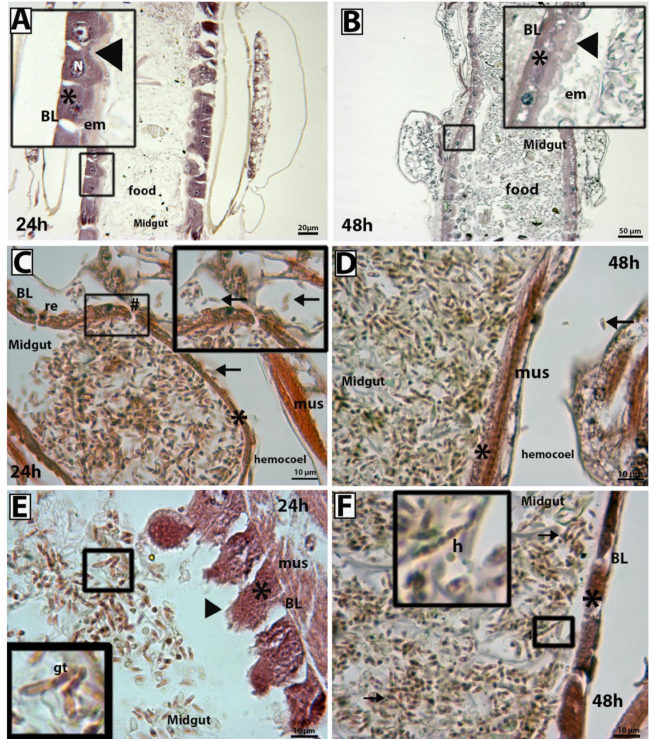
Figure 3. Histological analyses of Aedes aegypti larvae, stained with Hematoxylin and Eosin. Pho- tomicrographs of Ae. aegypti larva midgut at 24 h or 48 h after exposure to propagules of Metarhizium anisopliae s.l CG 153 or Tween 80 at 0.03% for 24 h (CTR). Tween 80 at 0.03% for 24 h ( A ) and 48 h ( B ); conidia at 24 h ( C ) and 48 h ( D ); and blastospores at 24 h ( E ) and 48 h ( F ). Larvae from the control group exhibited normal midguts composed of healthy enterocytes with acidophilic cytoplasm, pre- served brush border and normal extracellular material. After 24 h or 48 h, larvae exposed to conidia presented disrupted midguts with flattered enterocytes without brush borders and had hyphal bodies in the hemocoel. After 24 h, larvae exposed to blastospores showed enterocytes with disorganized cytoplasm and disrupted brush borders (black arrowhead). After 48 h, larvae exposed to blastopores exhibited midguts with flattered enterocytes without brush borders and the presence of hyphae in the gut lumen. BL = basal lamina; N = nucleus; * = cytoplasm of the enterocyte; brush border (black arrowhead); hyphae (h); enterocytes (asterisk); germ tube (gt); muscle (mus), disrupted midgut